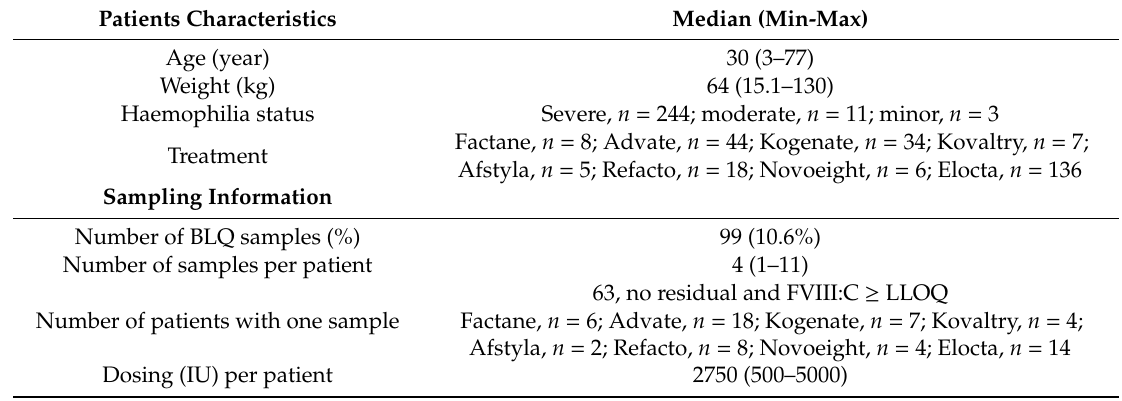
Table 1. Demographic characteristics and sampling information of the 258 patients included in the pharmacokinetic (PK)